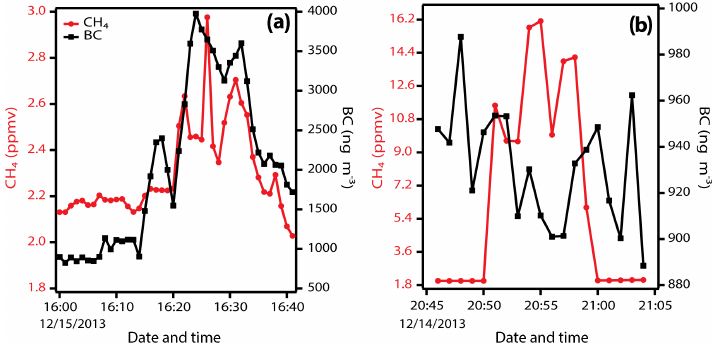
Figure 12. Concentrations of CH 4 (ppmv) and BC (ngm − 3 ) . (a) Measurements collected near a well with an active flare at Indian Hill; and (b) measurements collected downwind of a site in Painted Woods oil field, with multiple well-heads and collection tanks, but no flare. Note the difference in scale for the two plots.